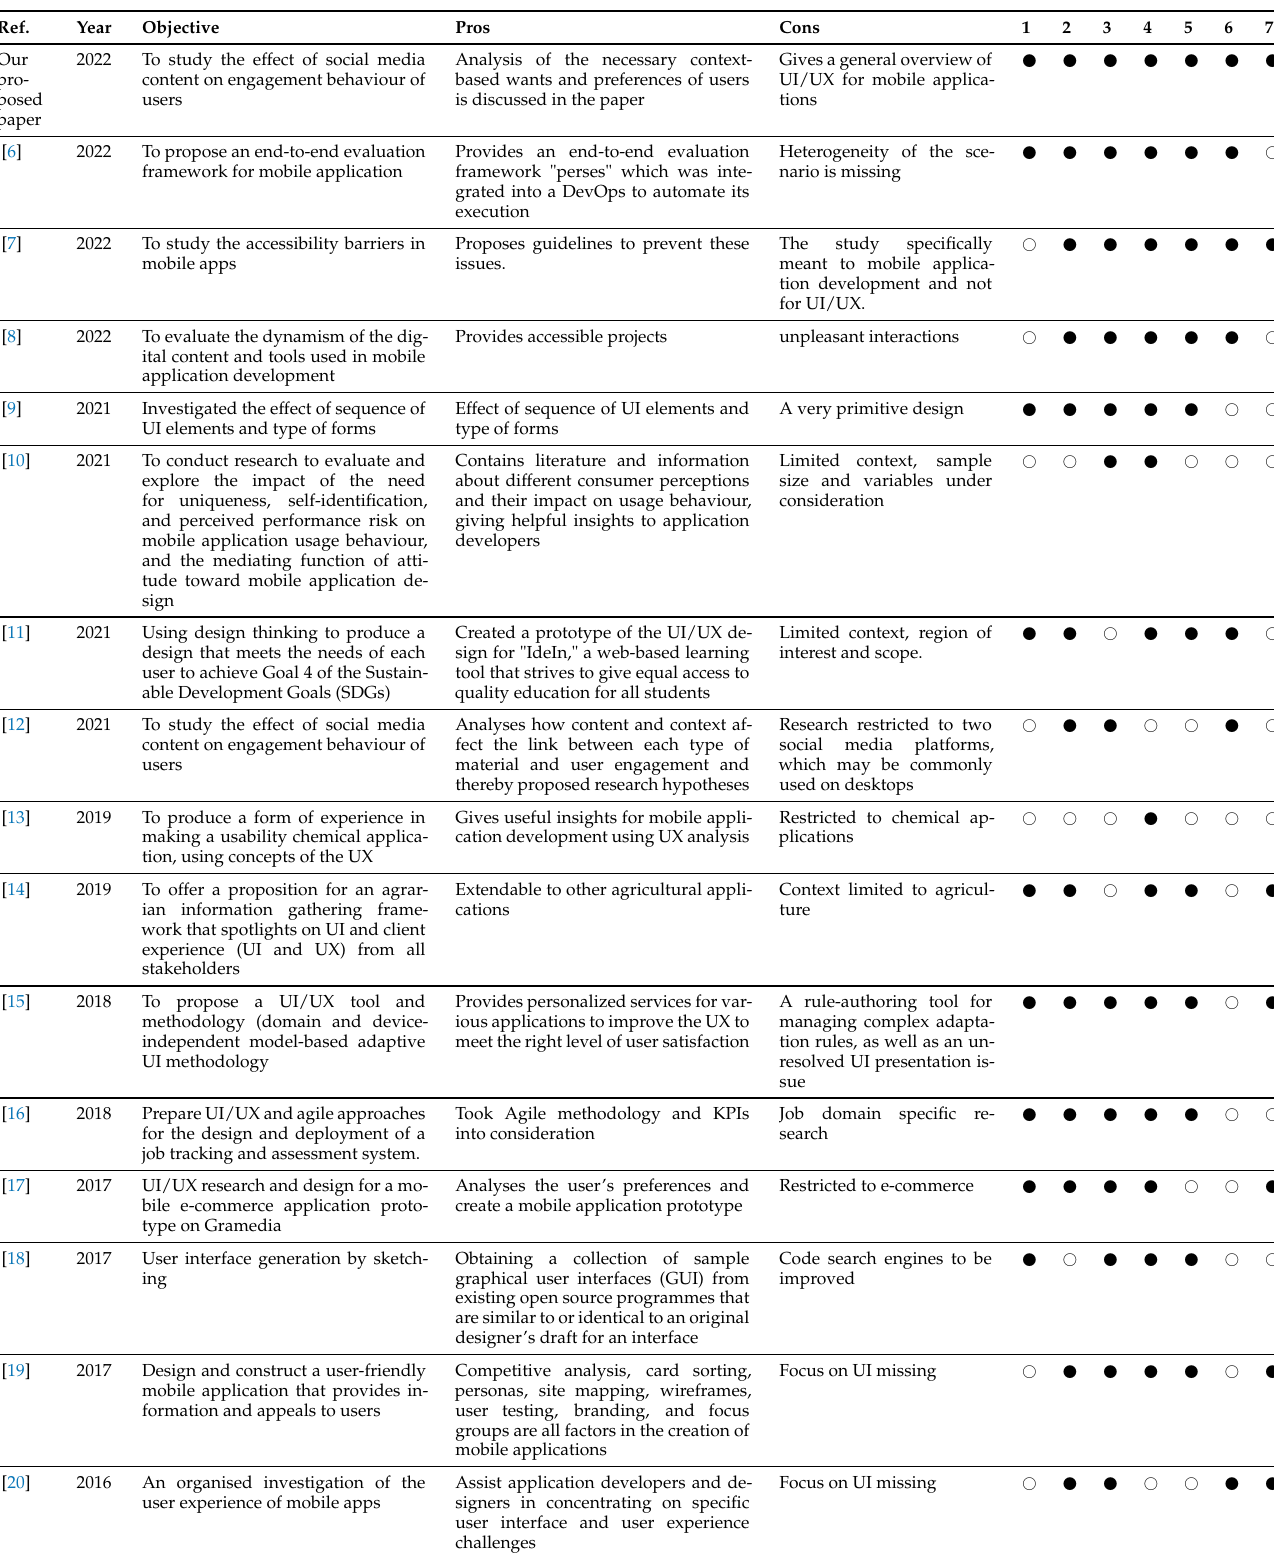
Table 1. Comparative survey of